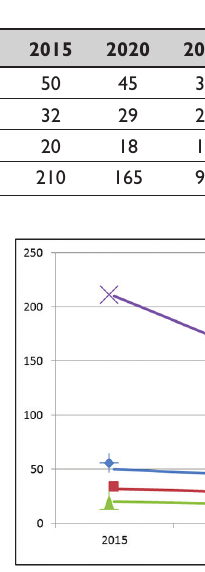
Figure 5 : Projections using LiST Tool in the year 2020, 2025 and 2030